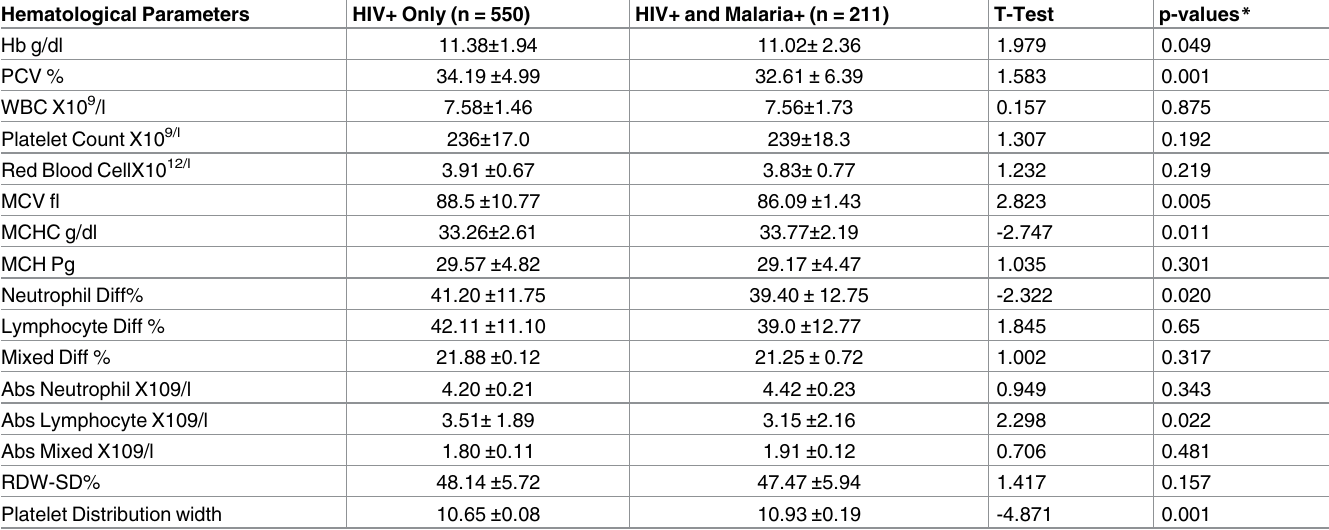
Table 4. Comparison of Hematological parameters Between HIV+ Patients and HIV+/Malaria+ Among Patient Attending ART Clinic at Infectious DiseaseHospital Kano Between June to December 2015 (n = 761). Hematological Parameters HIV+ Only (n = 550)